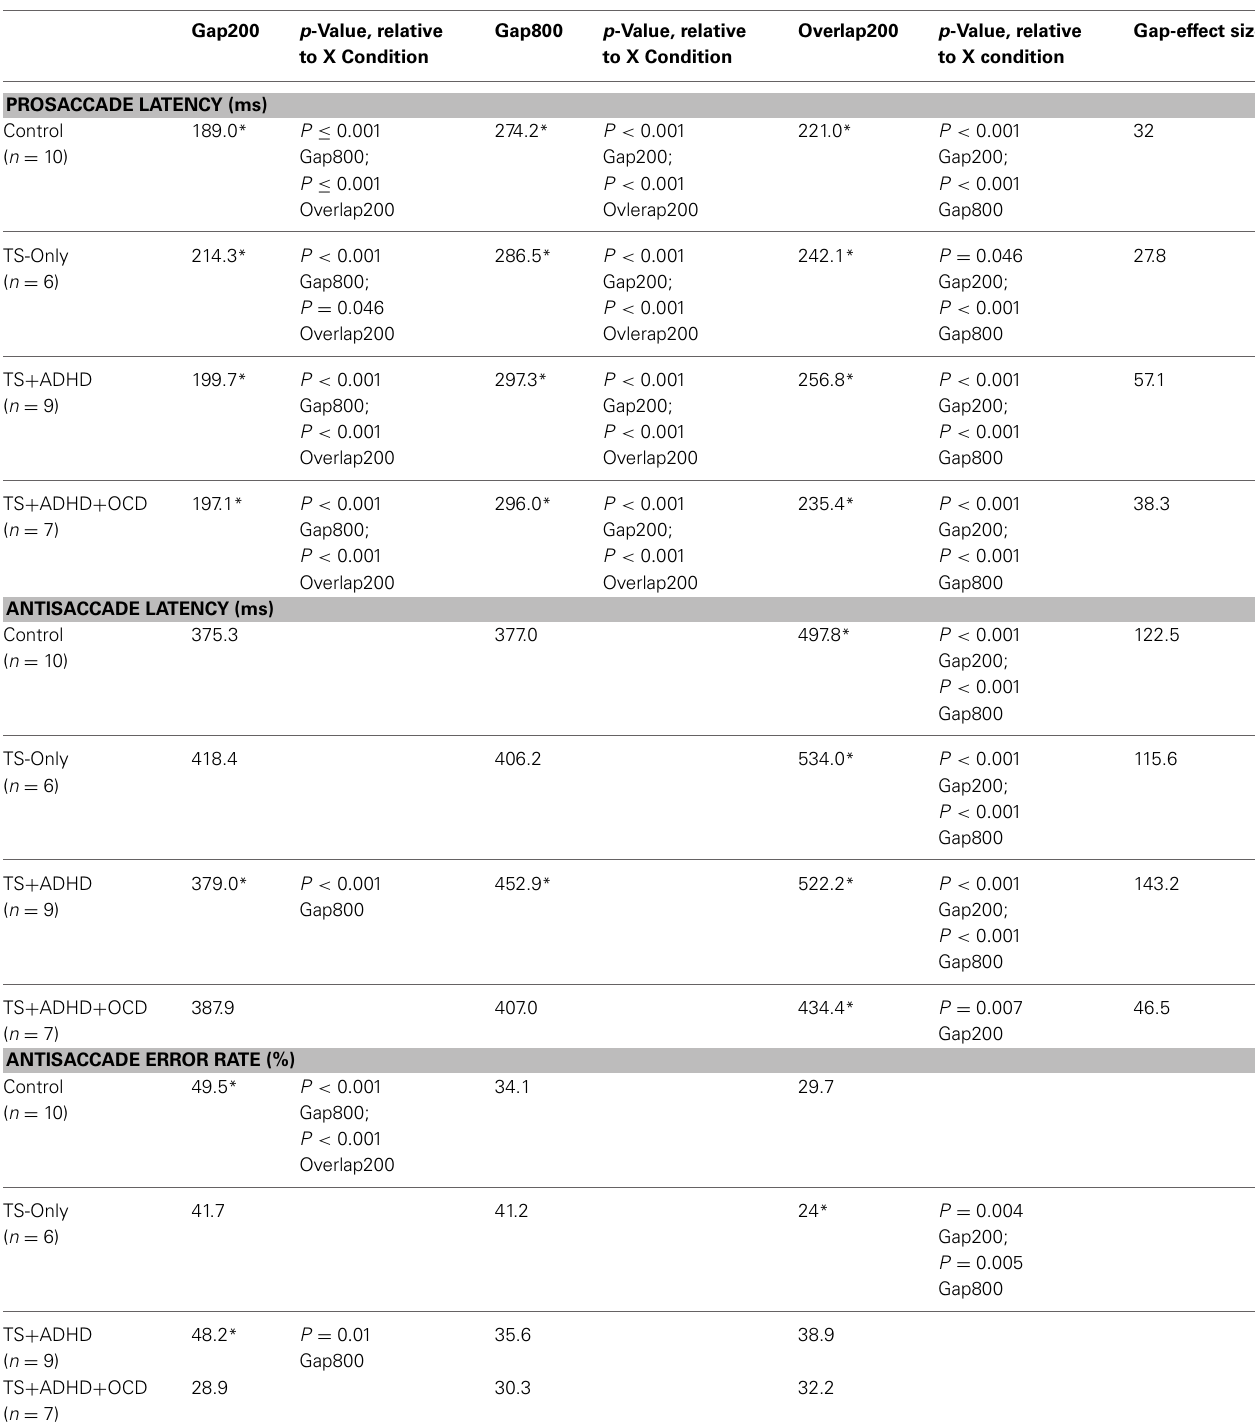
Table 1 | Average saccade latencies and error rates of each group across the three fixation offset conditions. Gap200 p -Value, relative Gap800 p -Value, relative Overlap200 p -Value, relative to X Condition to X Condition to X